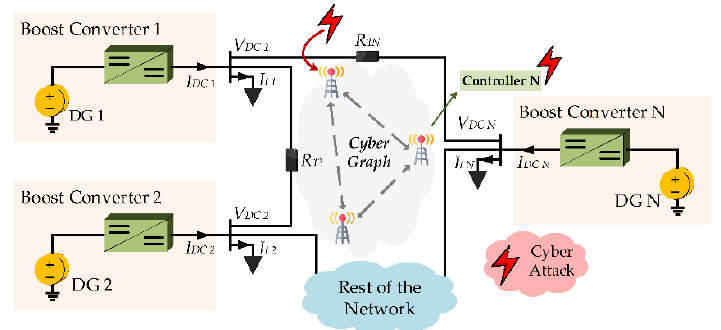
Figure 4. DC microgrid with the cyber–physical model.